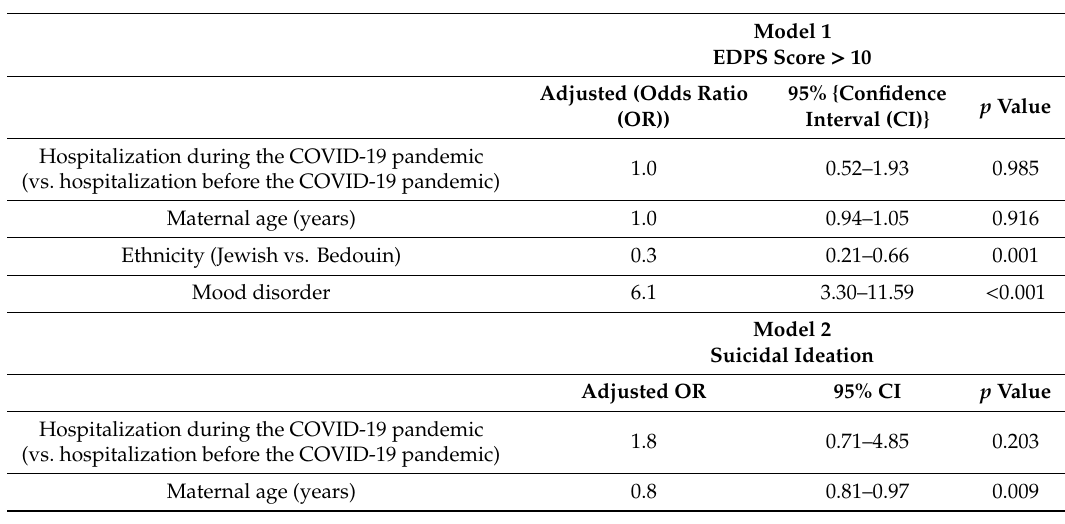
Table 4. Multivariable logistic regression model for the association between timing of hospitalization and EDPS score ≥ 10.